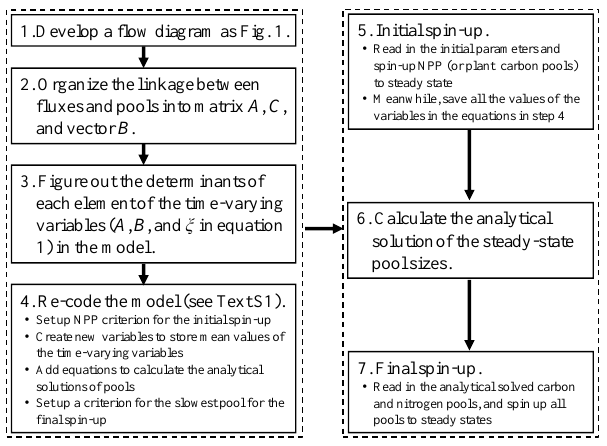
Fig. 2. The spin-up strategies of the spin-up method with the semi- analytical solution (SAS) used in this